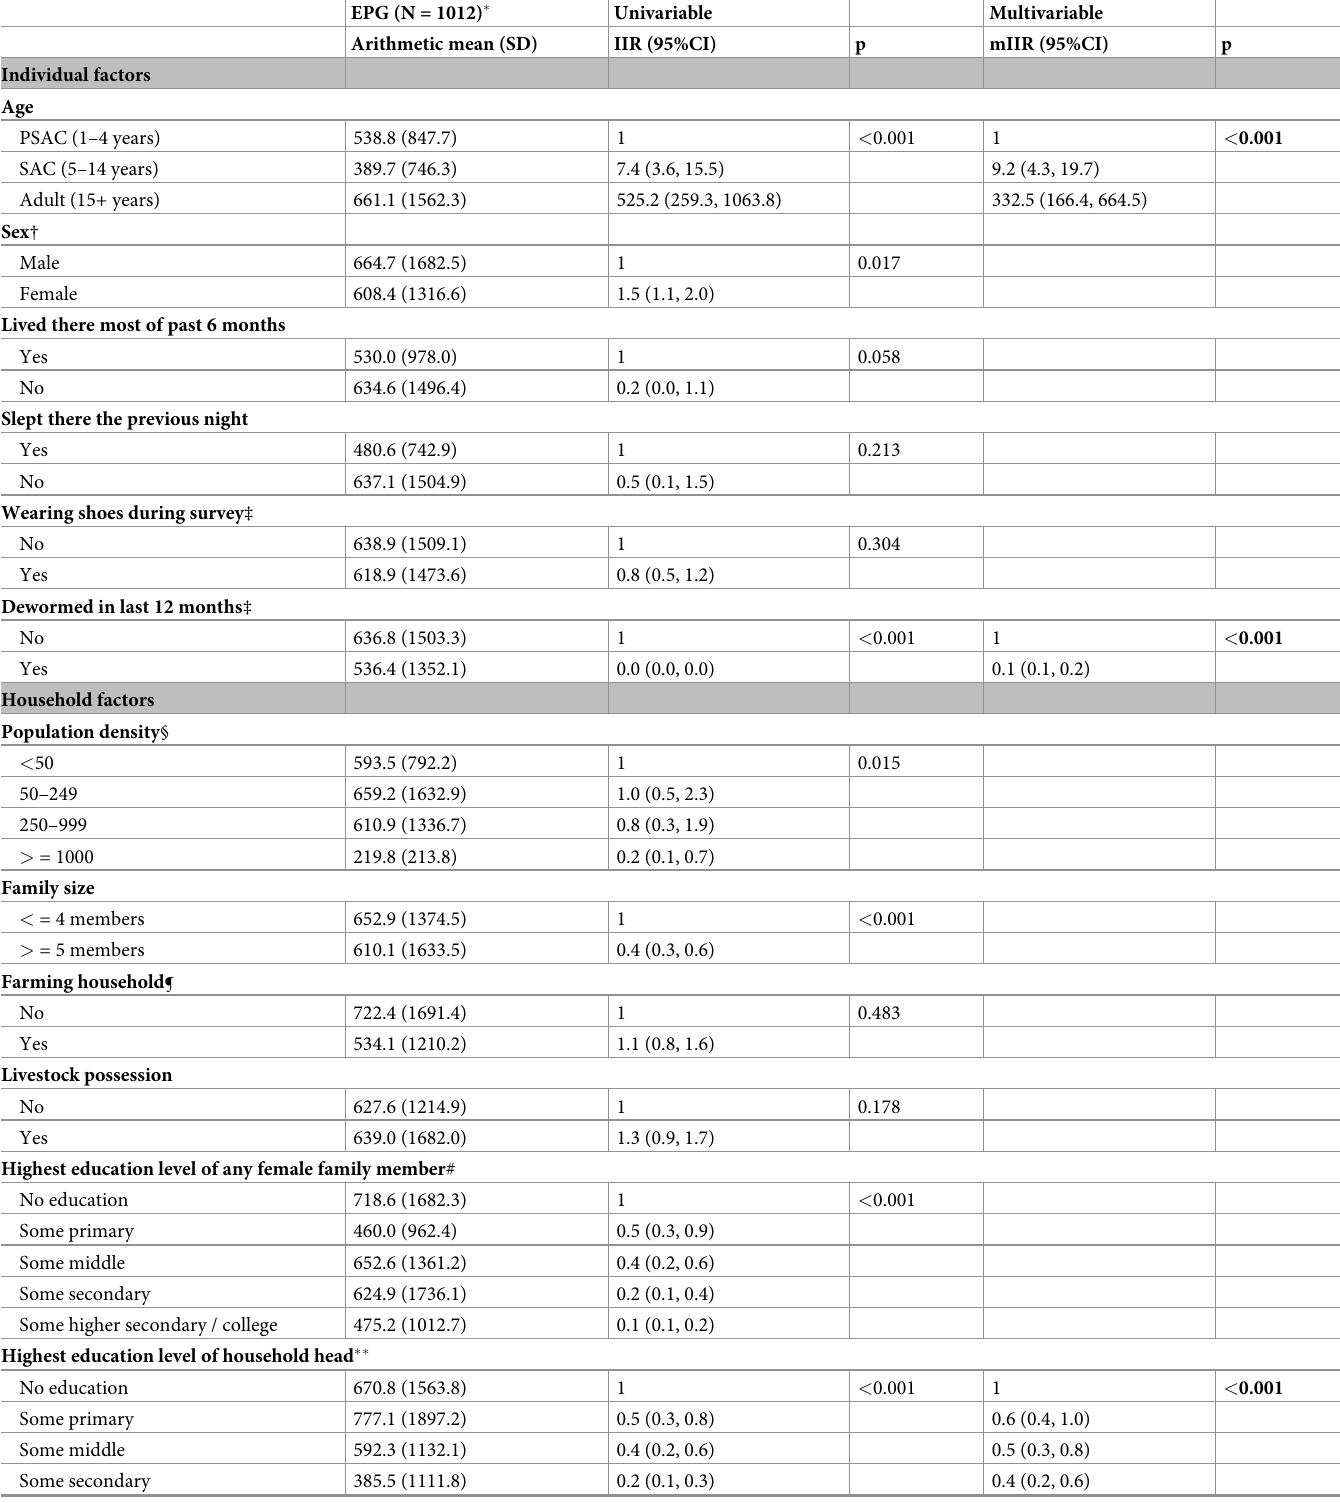
Table 3. Univariable and multivariable analysis of factors associated with intensity of hookworm